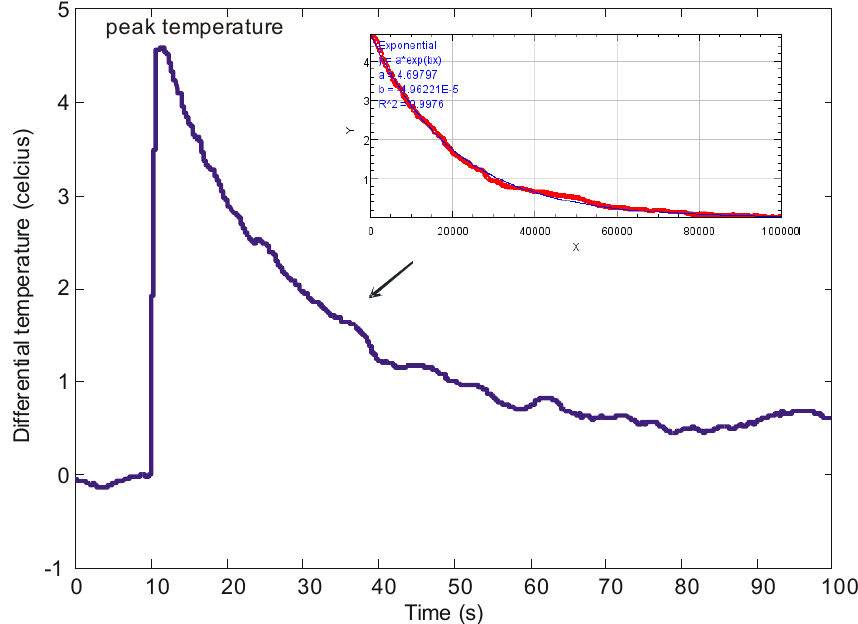
Figure 5. The y-axis represents the difference between the peak temperature and ambience temperature, referred to as relative temperature in this paper. In this particular example, the exothermic reaction produces almost a 5 °C rise in temperature. Once the exothermic reaction is completed, the droplet cools down exponentially to reach equilibrium. The inset figure shows the curve fitted graph to find the cooling